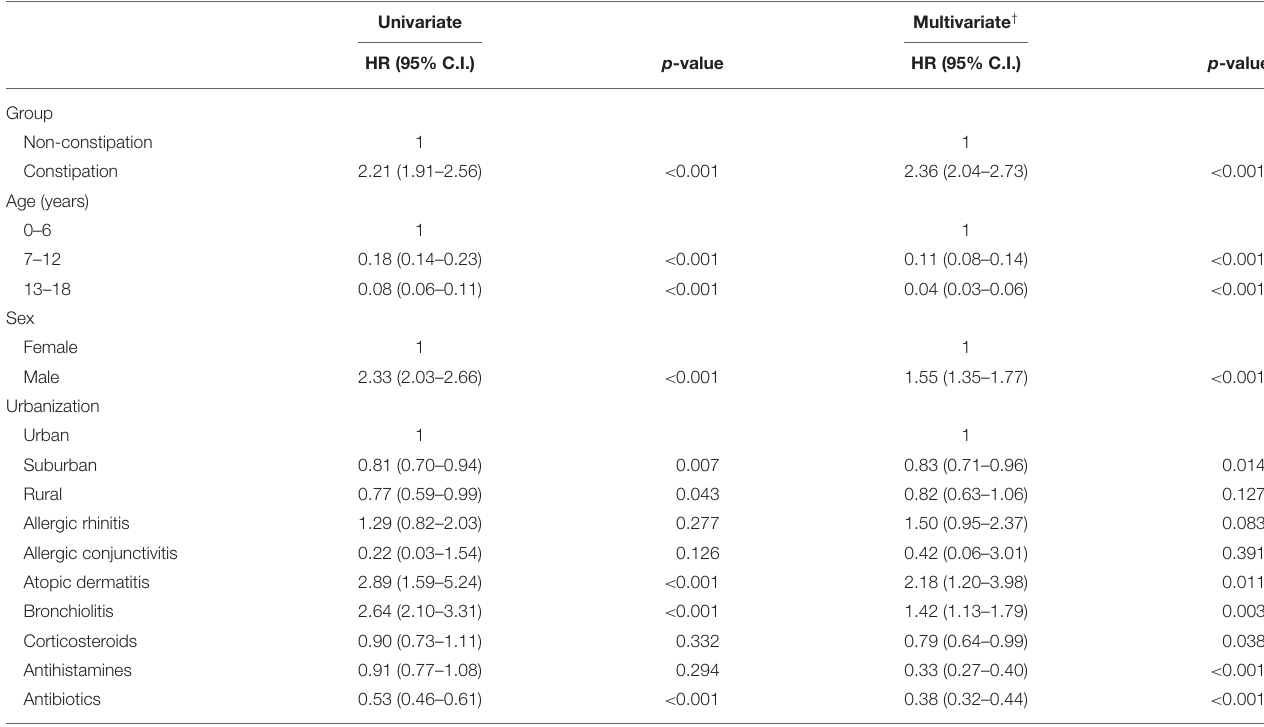
TABLE 2 | Cox proportional hazard model analysis for risk of asthma.